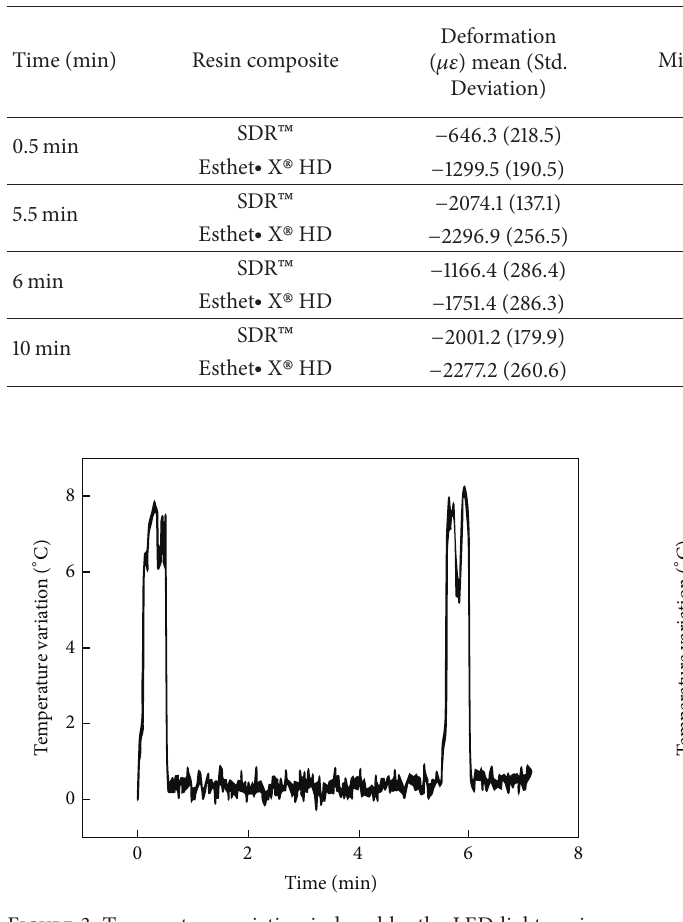
Figure 3: Temperature variation induced by the LED light-curing unit.